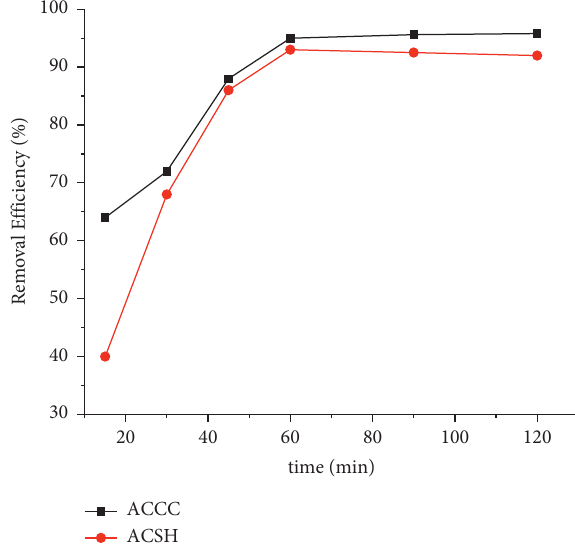
Figure 4: Effect of contact time on the removal of fluoride using activated carbon of corncob and sorghum husk (dose � 6 g, with an initial fluoride concentration of 5.0